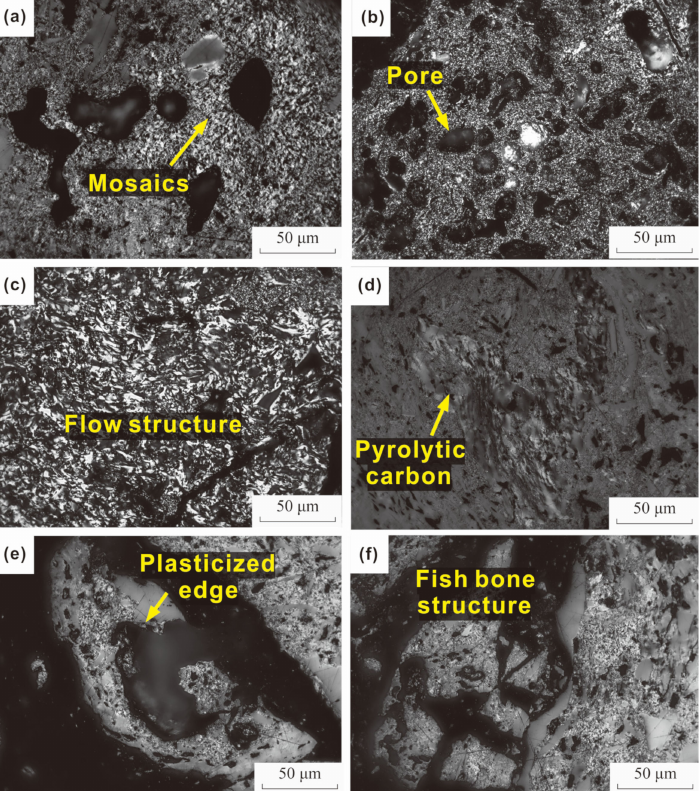
Figure 5. Photomicrographs of thermally altered organic particles in the Tashan coal at a magnifica- tion of 500 × with white reflected light and immersion oil under the optical microscope: ( a , b ) pores related to devolatilization and massive altered organic particles exhibiting mosaic microtextures; ( c ) massive altered organic particles exhibiting flow structure; ( d ) pyrolytic carbon exhibiting promi- nent anisotropy fills in fissures; ( e ) altered organic particles showing plasticized edge; ( f ) altered organic particle with cracks exhibiting ‘fish bone’